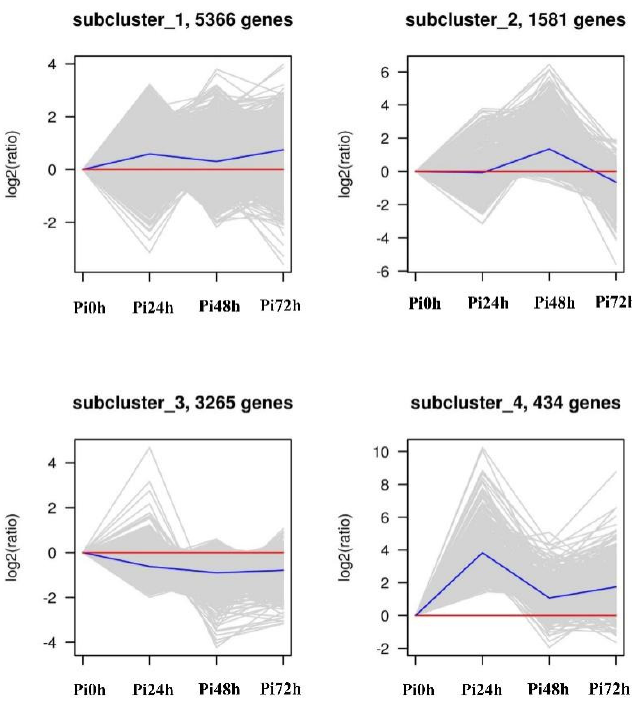
Figure 3. Temporal dynamics of Qingshu 9 differentially expressed genes. The DEGs of Qingshu 9 were clustered by k − mean. The gray lines in each figure represent the line graphs of the relative expression levels of genes in a cluster under different infection times, the blue lines represent the line graphs of the average relative expression levels of all genes in the cluster under different infection times, and the red lines represent the baseline. The x − axis represents the experimental conditions, and the y − axis represents the relative expression. The area above the red line represents upregulated genes, and the bottom area represents downregulated genes.